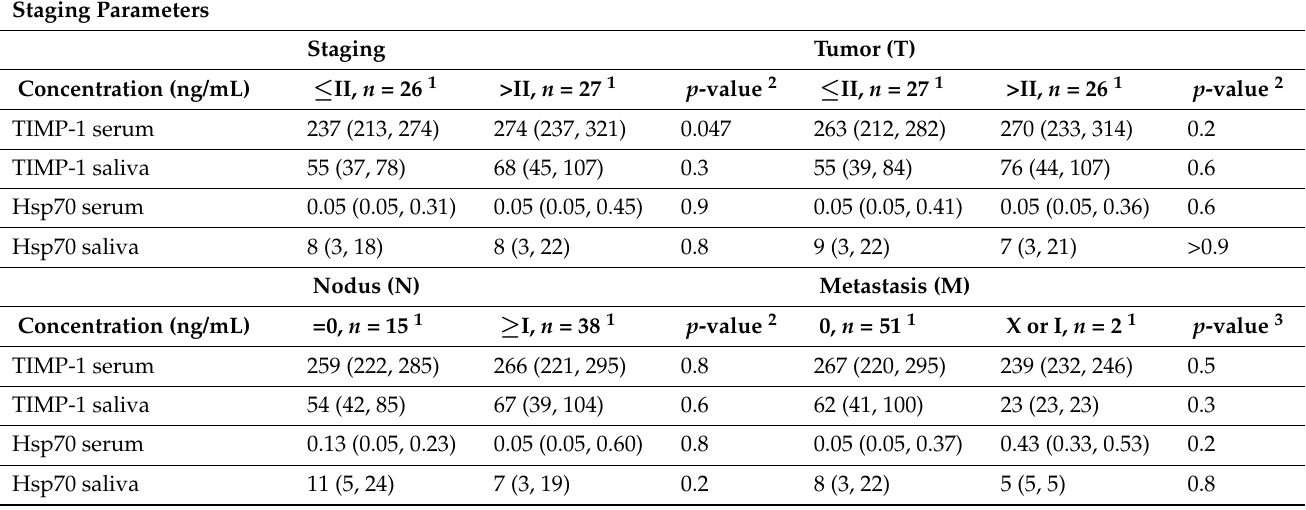
Table 3. Protein concentration and staging parameters of HNSCC patient pretreatment samples ( n = 53).